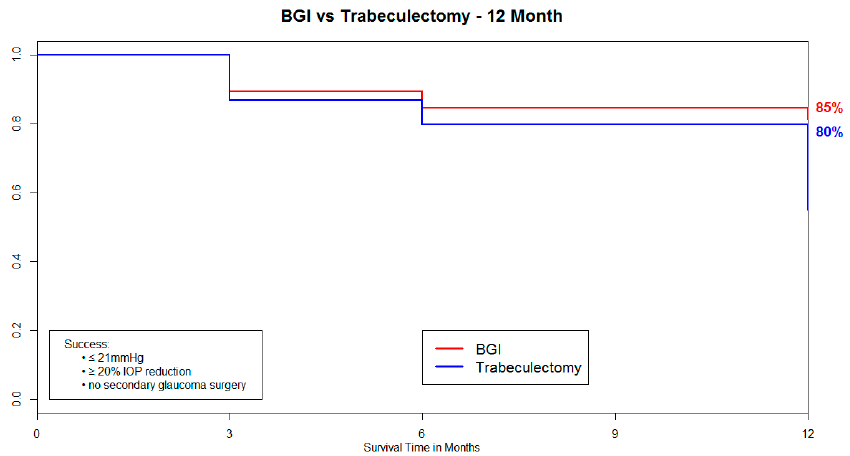
Figure 1. Survival curves of two groups.